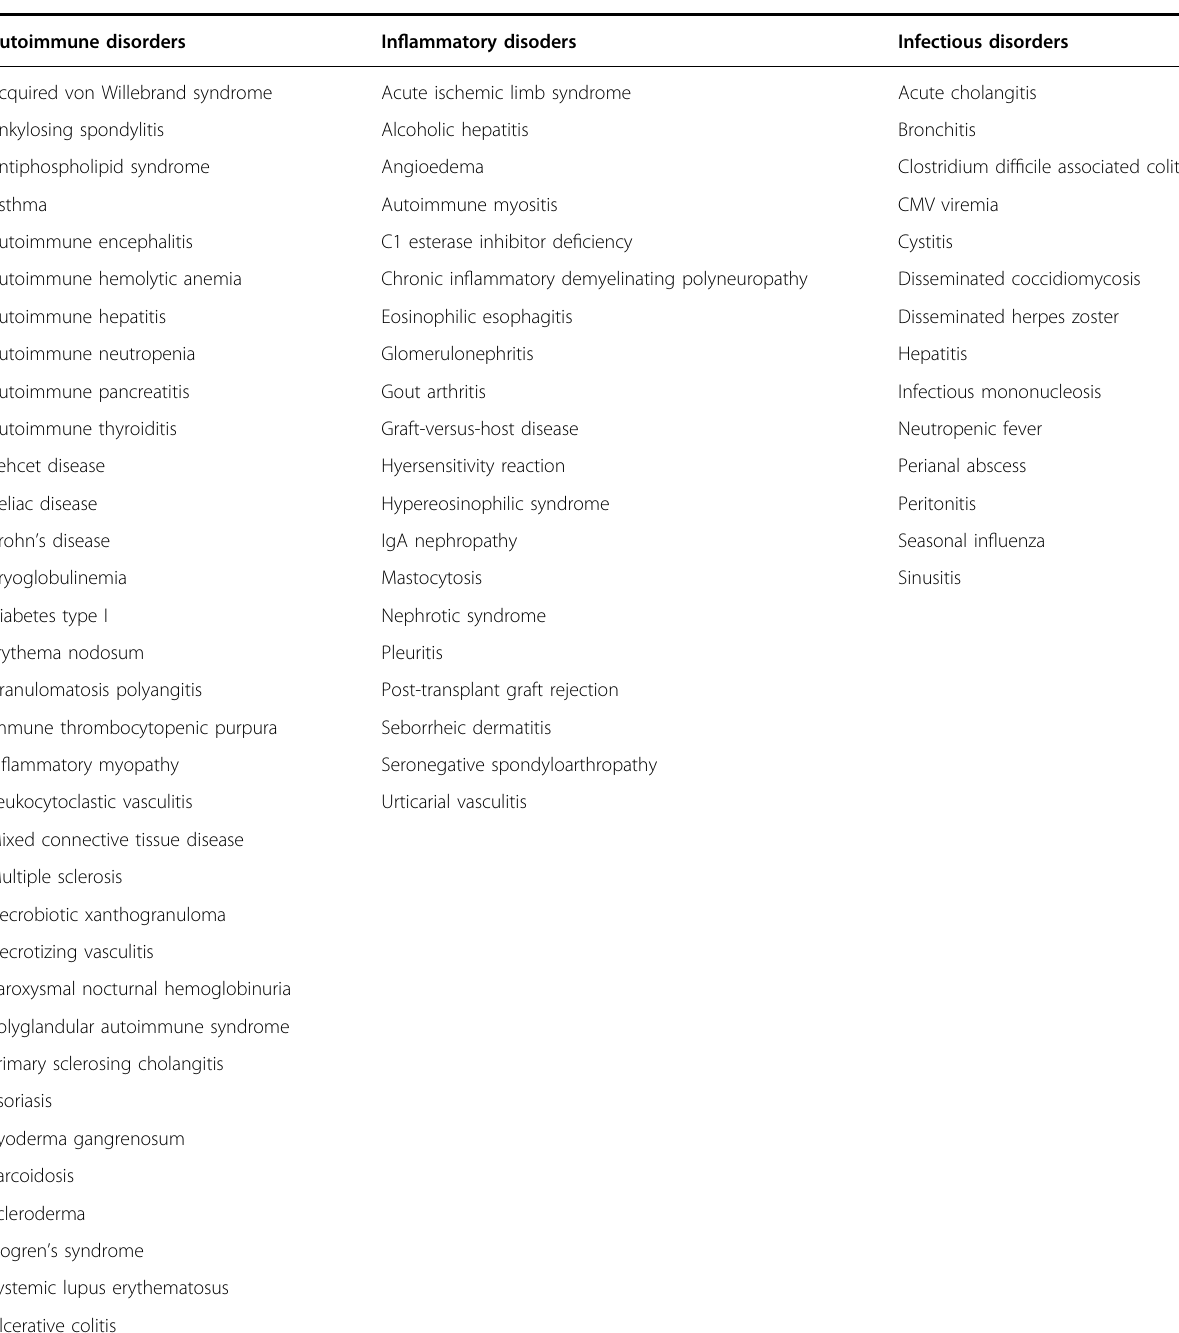
Table 2 Immune-related